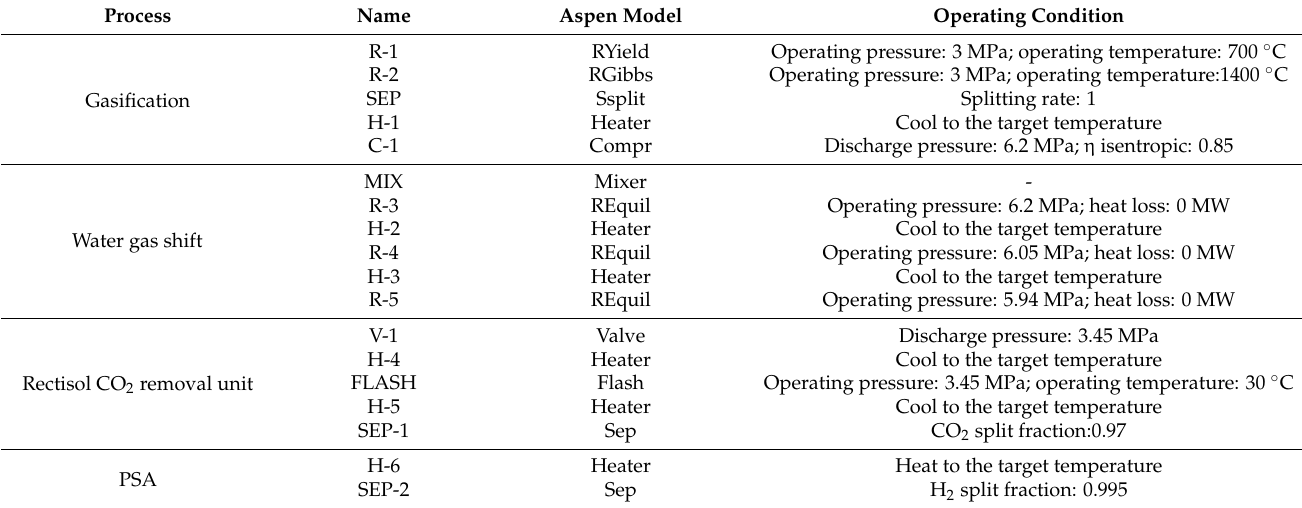
Figure A1. CtH process. Table A1. Models and parameters adopted in the CtH simulation Table A1. Models and parameters adopted in the CtH simulation process.